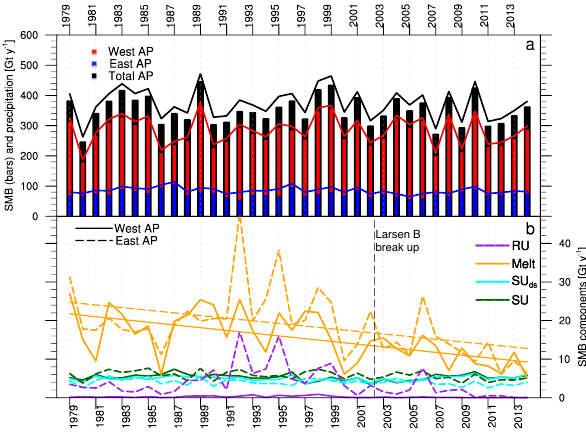
Figure 7. Yearly average SMB (a) and SMB components (b) in Gtyr − 1 . For SMB, values for the WAP (red) and the EAP (blue) are shown. SMB is integrated over basins 24, 25, 26 and 27 from Zwally et al. (2012). Trend lines are only shown if significant. From 2003 onwards integrated values represent the ice shelf excluding Larsen B ice